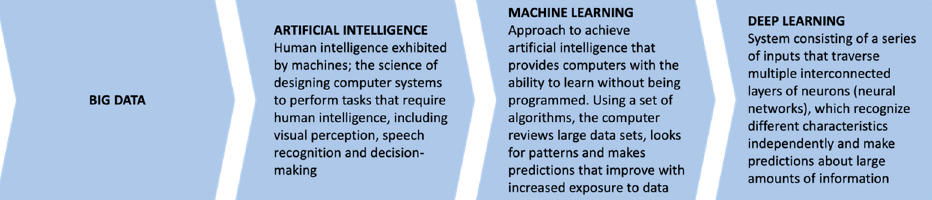
Figure 1. This flowsheet defines and clarifies relevant terms and concepts used throughout the article. “Big Data” can be applied to multiple processes that are within the realm of artificial intelligence. Machine learning and deep learning are subsets of artificial intelligence, and each process uses “big data” as inputs.